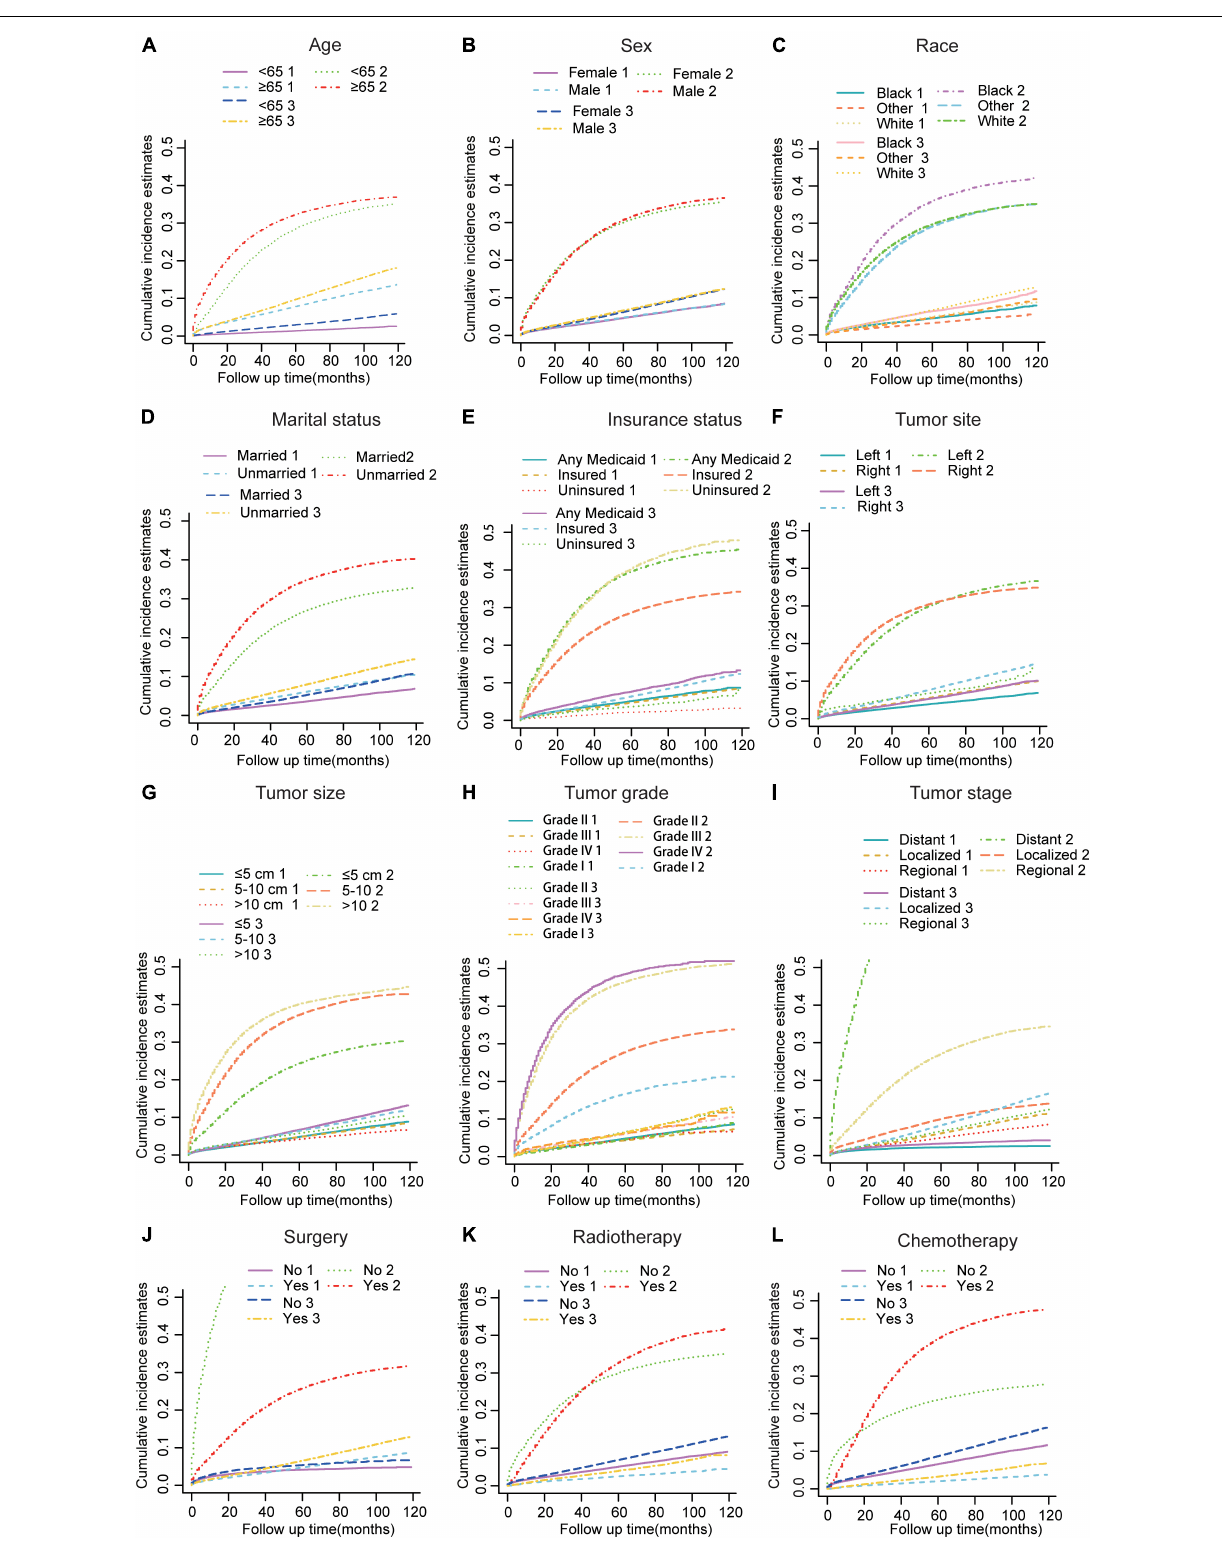
Frontiers in Cardiovascular Medicine |